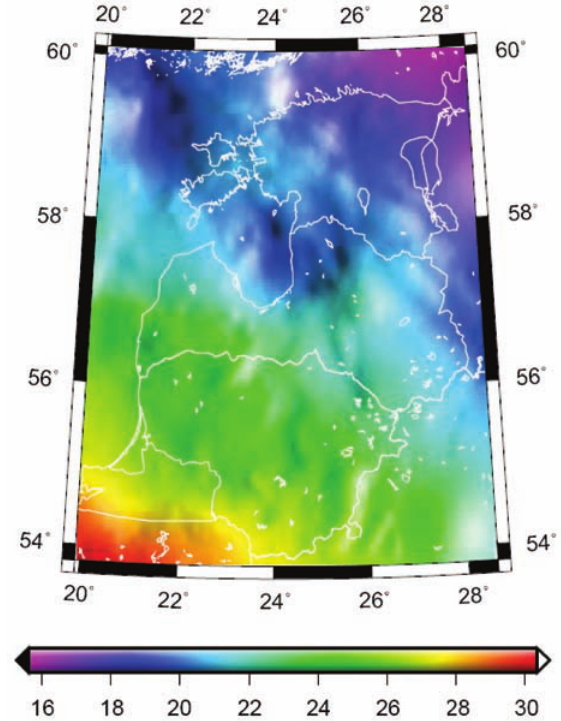
Fig. 2. The Baltic gravimetric geoid model BALTgeoid-04 (Ellmann, 2005) computed by the unbiased least squares modified Stokes’s formula. Geoidal heights are given with respect to the GRS-80 reference ellipsoid. Unit is metre. The total area of the image corresponds to 300 000 km